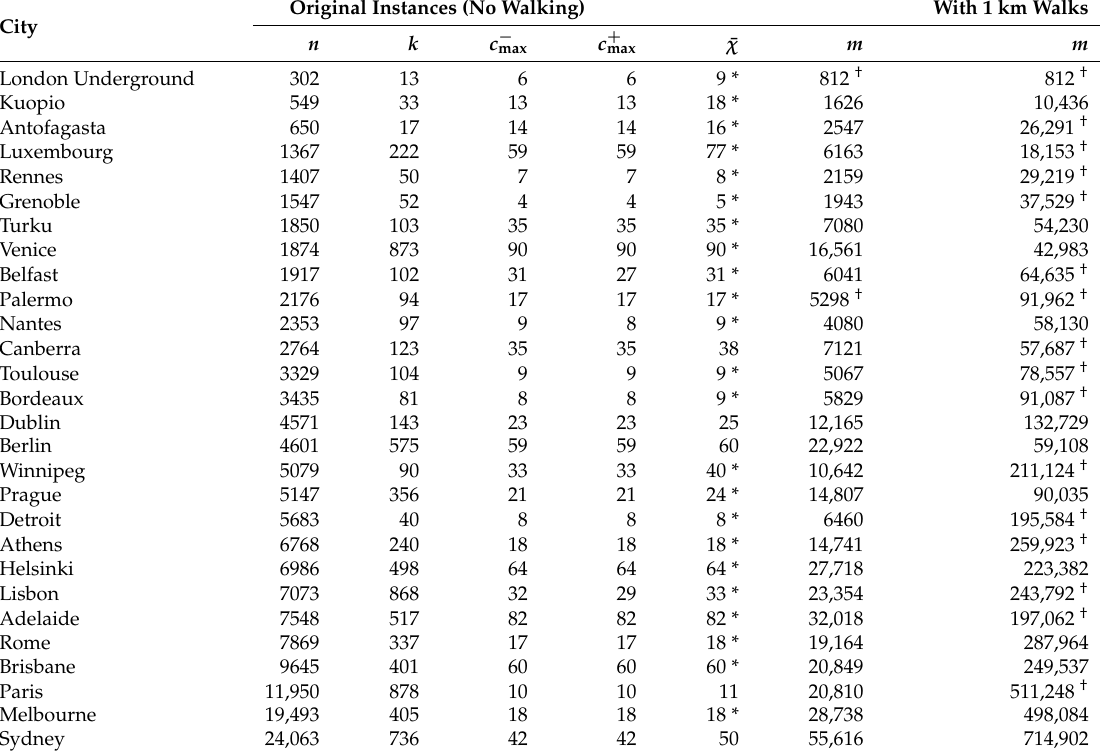
Table 2. Summary of the 28 real-world problem instances. In columns indicating the number of edges m , daggers (†) indicate strongly connected graphs. For instances with 1 km walks, an extra edge colour is required, meaning that k and ¯ χ should be incremented by one. The meaning of the asterisks (*) is described in the